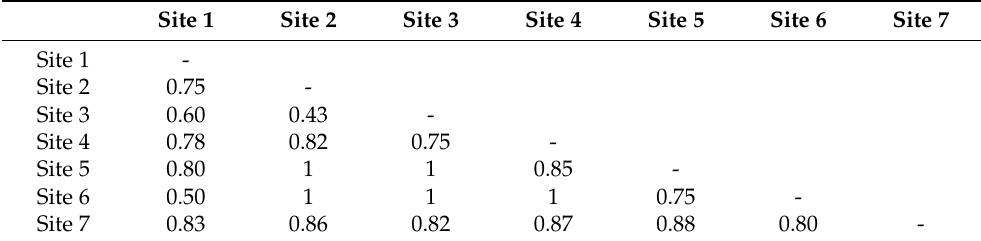
Table 4. Sorensen matrix of